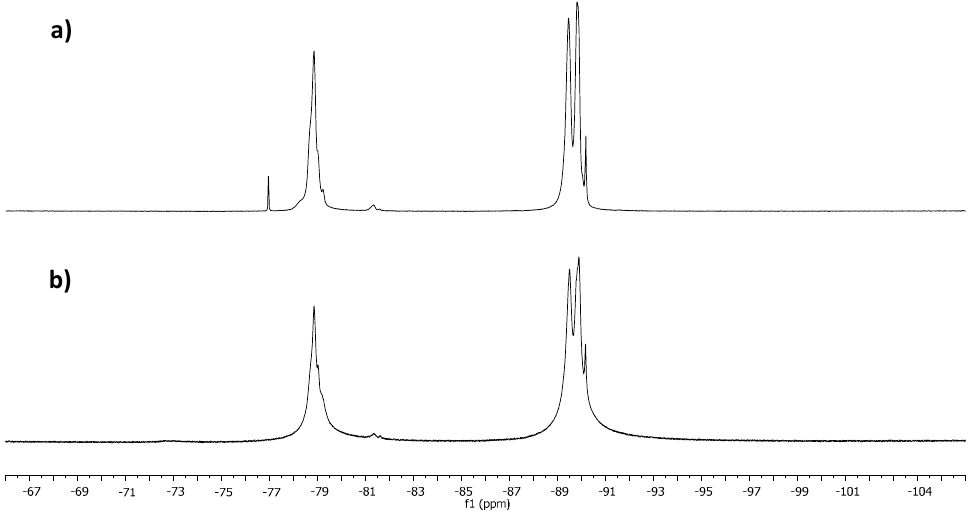
Figure 3. ( a ) 19 F NMR (470 MHz, CD 3 OD) of NP-C6OF-PEG and ( b ) of NP-C6OF-PEG / C6OF-DO3AGd. NP-C6OF-PEG/C6OF-DO3AGd.